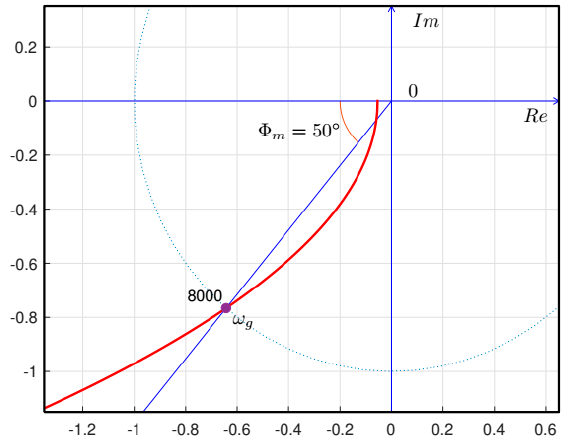
Figure 9. Bode diagrams of the frequency response of the 3-leg interleaved buck converter average model (green) and of the open-loop frequency response with the proposed control (red). ( a ) Bode magnitude plot; ( b ) Bode phase plot.